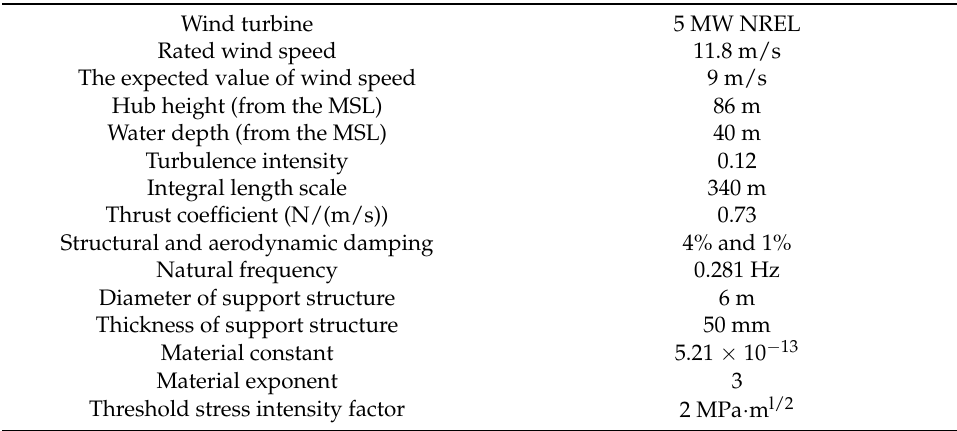
Figure 2. Typical monopile OWT structure. Table 1. Characteristics of the monopile OWT [27–29].